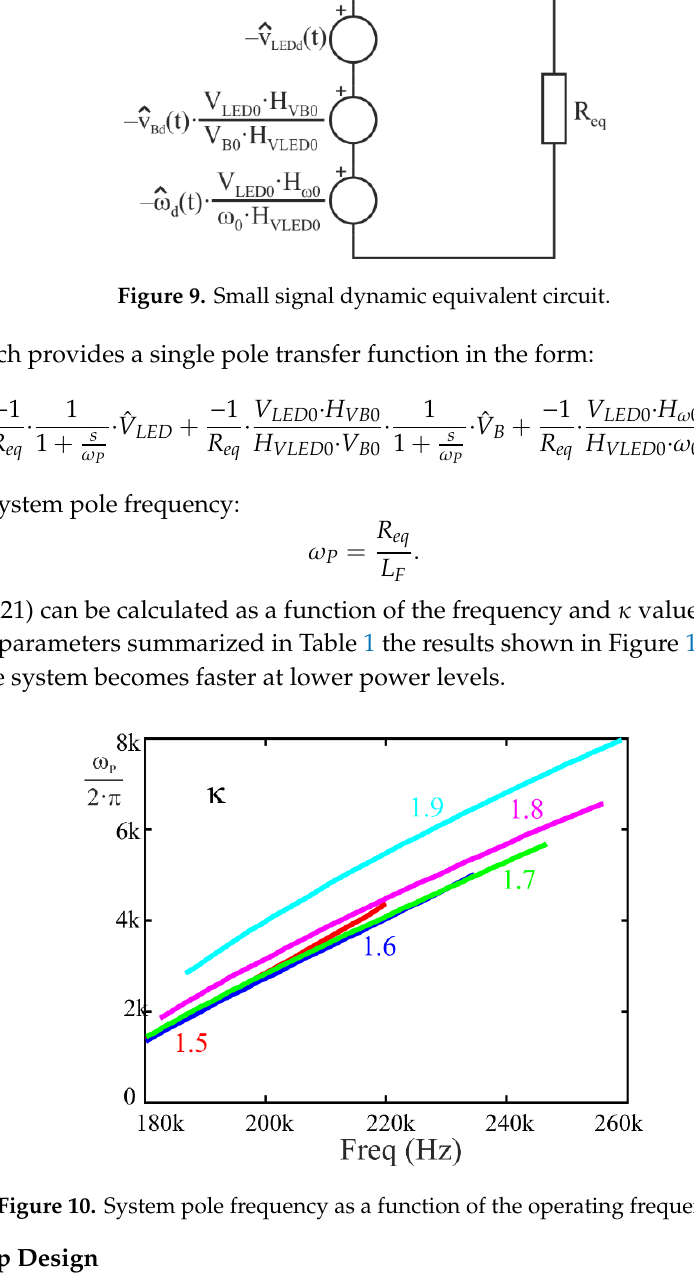
Figure 11. Small signal control loop.